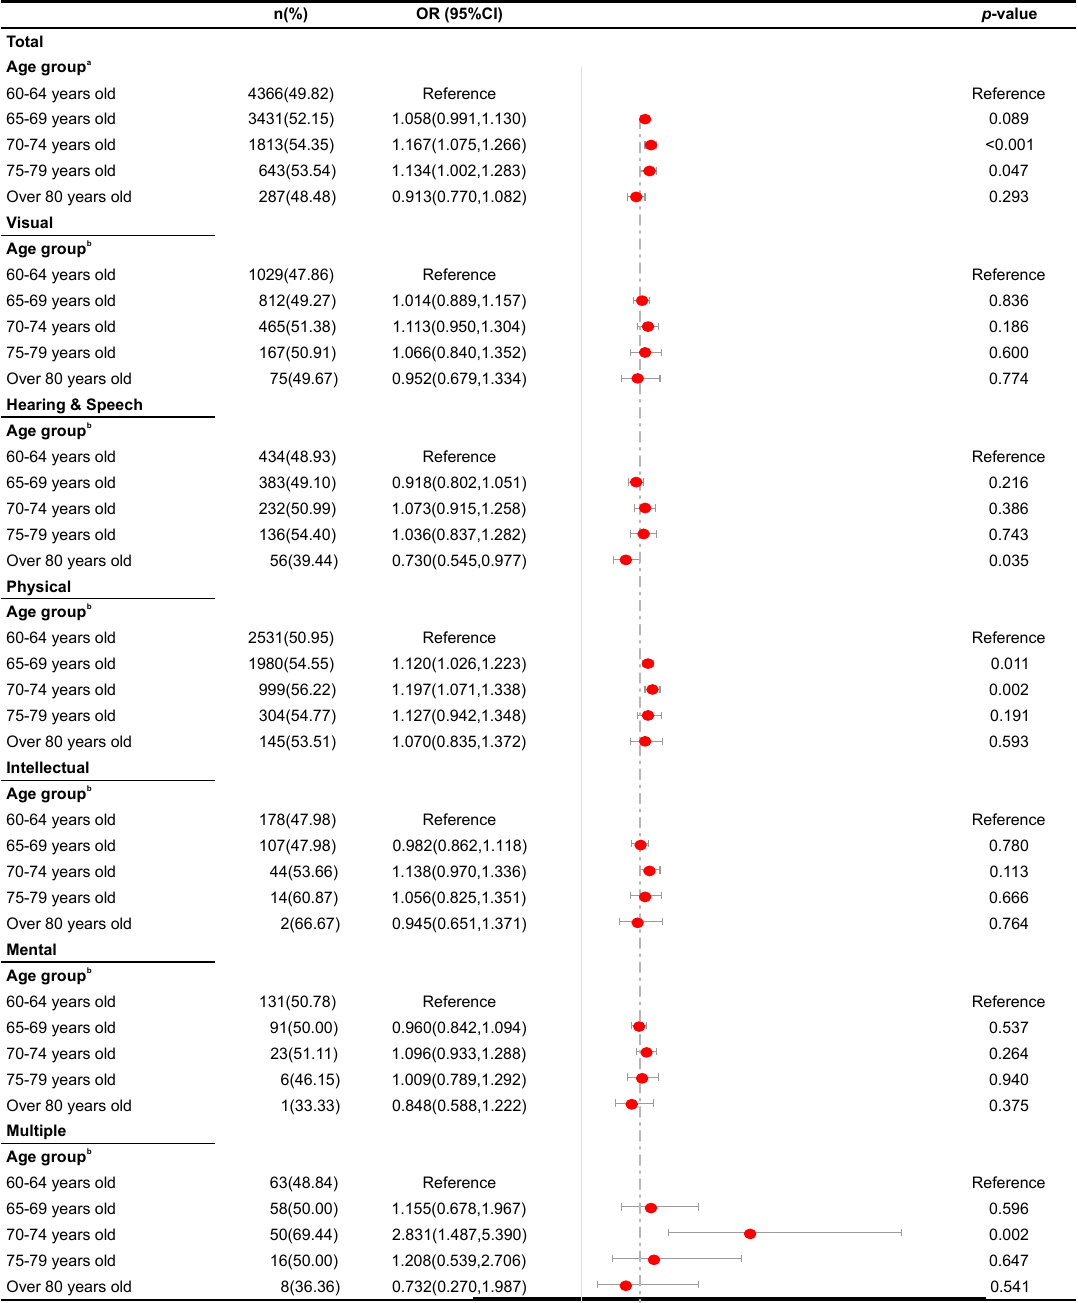
Figure 4. Results of a logistic regression analysis of overweight according to age group across disability types. a Adjusted for sex, residence permit, education level, marital status, disability type, and disability severity. b Adjusted for sex, residence permit, education level, marital status, and disability severity.